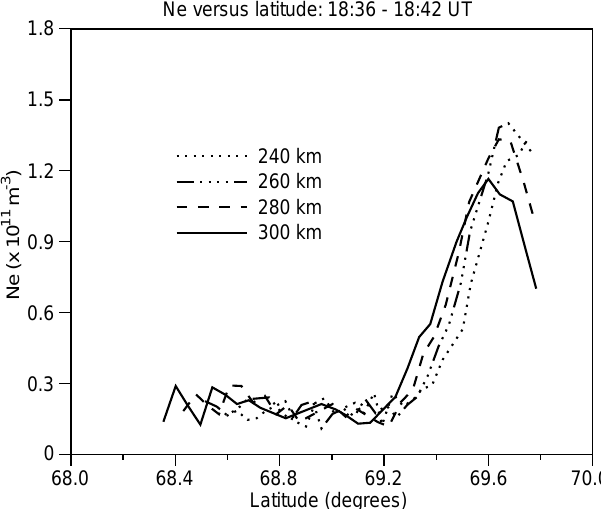
Fig. 5. Electron densities at 280 km altitude as a function of latitude measured during eight successive scans of the radar, each identified by the